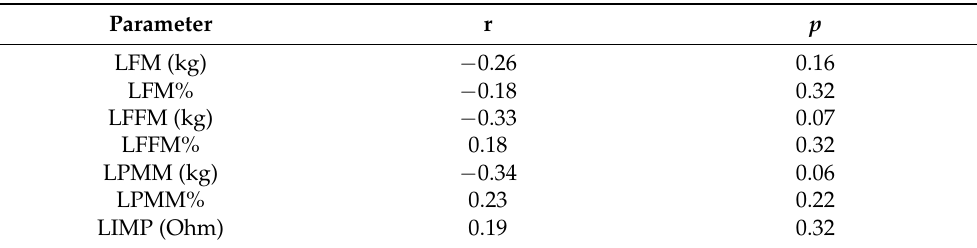
Table 7. Spearman correlations between the mass composition and mean spasticity of the affected lower limbs (n = 31).